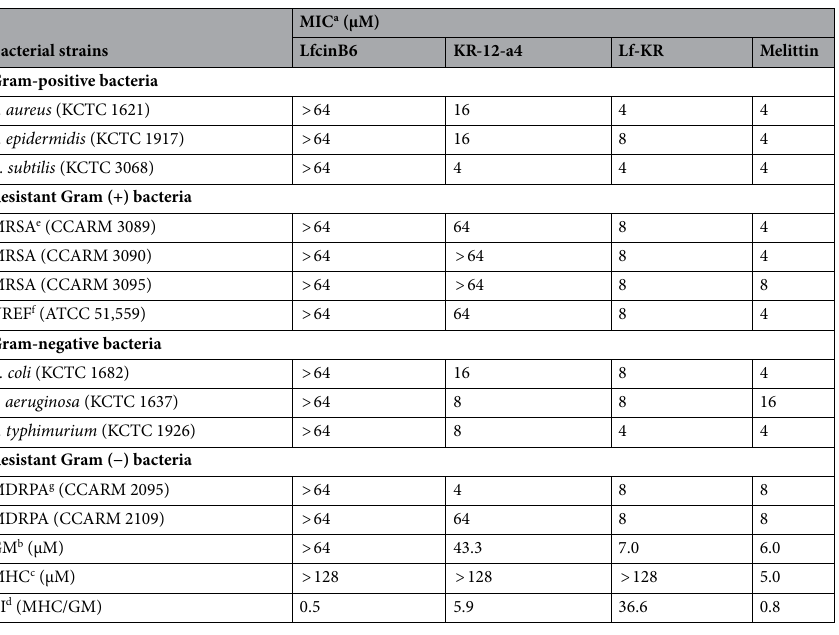
Table 2. MIC, MHC and TI of LfcinB6, KR-12-a4 and Lf-KR against different bacterial strains. a Minimum inhibitory concentrations (MICs) were determined as the lowest concentration of the peptides that inhibited bacterial growth. b The geometric mean (GM) of the peptide MICs against the tested bacterial strains was calculated. When no antimicrobial activity was observed at 64 μM, a value of 128 μM was used to calculate the therapeutic index. c MHC is the minimum hemolytic concentration that causes 10% hemolysis of sheep red blood cells (sRBCs). When no detectable hemolytic. activity was observed at 128 μM, a value of 256 μM was used to calculate the therapeutic index. d Therapeutic index (TI) is the ratio of MHC to GM. Larger values indicate greater cell selectivity. e MRSA: methicillin-resistant Staphylococcus aureus. f VREF: vancomycin- resistant Enterococcus faecium. g MDRPA: multidrug-resistant Pseudomonas aeruginosa.